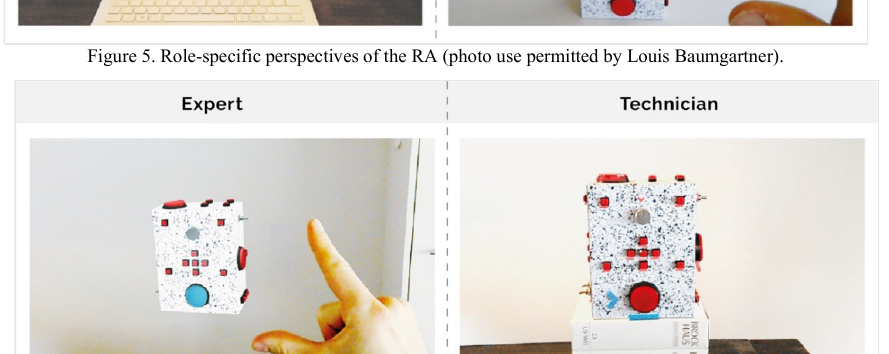
Figure 6. Role-specific perspectives of the DT